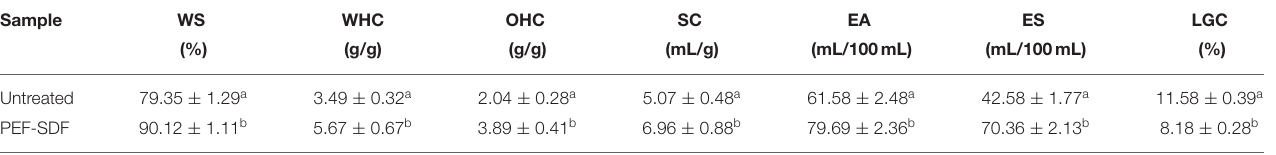
TABLE 2 | Effects of PEF A on physicochemical properties of orange peel